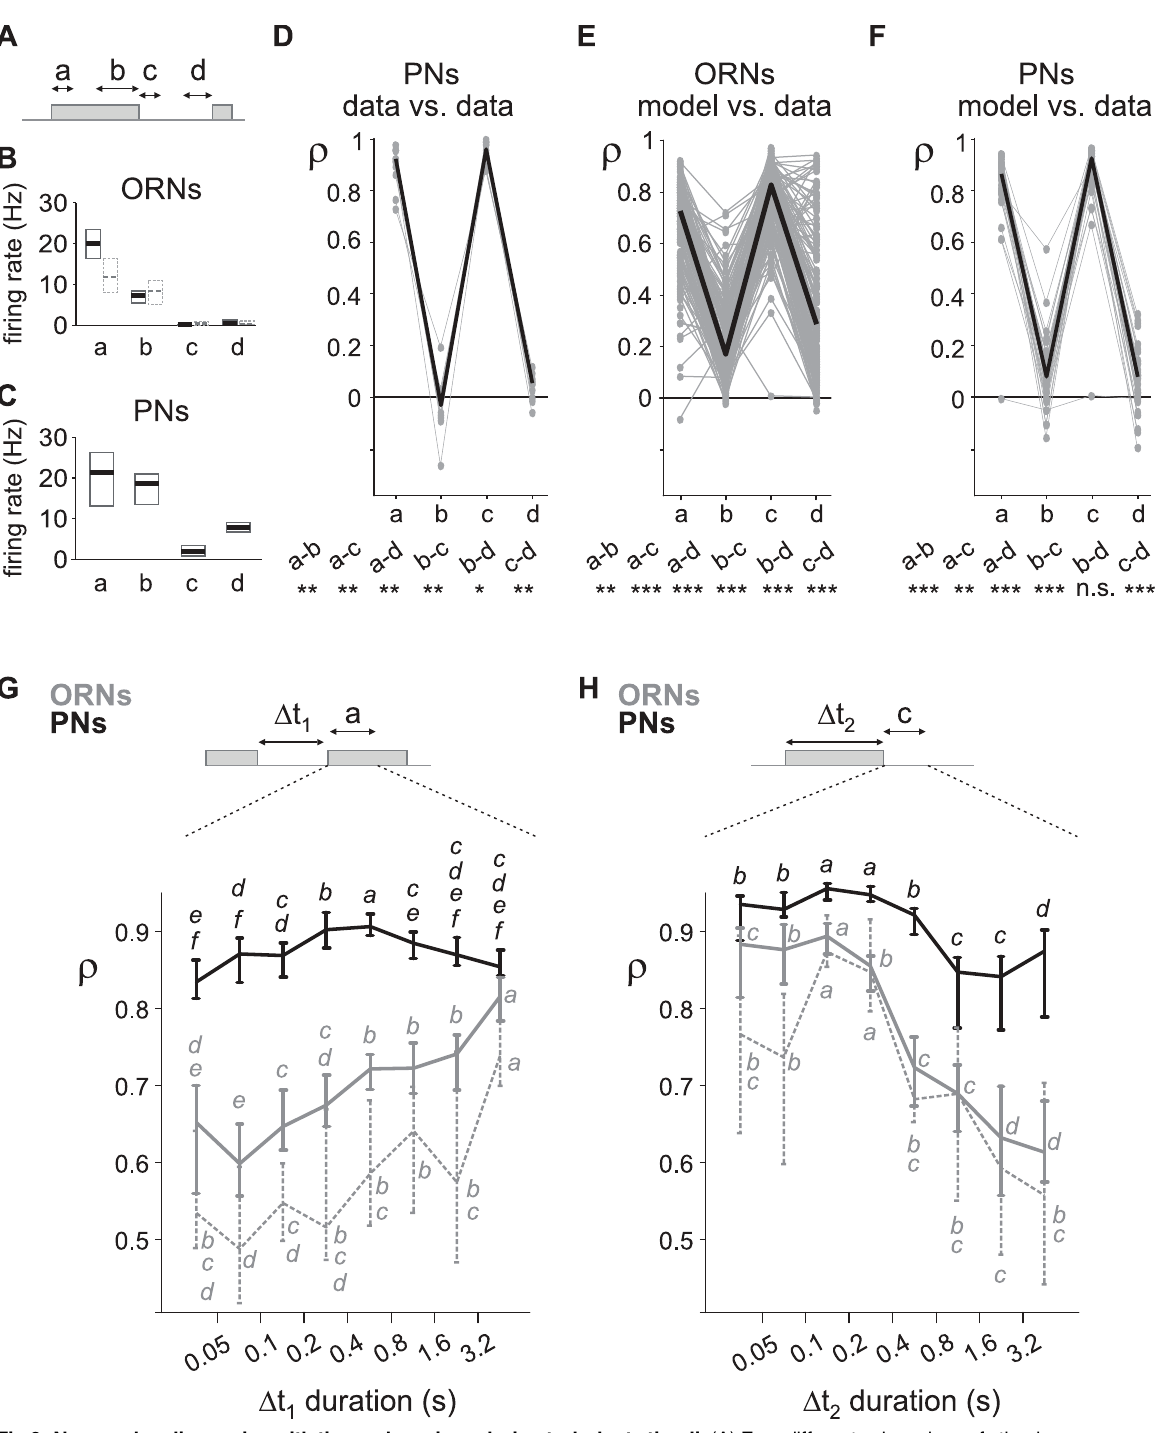
Fig 8. Neuronal coding varies with time sub-regions during turbulent stimuli. (A) Four different sub-regionsof stimulus sequenceswere definedwith (a) onset of puffs, (b) end of long puffs, (c) offset of puffs and (d) end of long blanks; see text for detailed definition.(B) (ORNs and in dotted grey the subpopulation of ORNs stimulatedwith pheromone loads of 10 -5 and 10 − 4 ng) and (C) (PNs): median values and bootstrapconfidenceintervals(95%) of firing rate in the 4 sub-regions.(D) Correlation coefficient between consecutive responses of PNs to a sequenceturbulent stimuli for the 4 sub-regionsdefinedin (A). Distance was 16 m. Cell number= 13. For each cell, 4 grey dots joinedby a grey line represent the medianvalues of correlationcoefficients θ duringsub- regions.Black line joins the median values. Bottom: dual tests betweensub-regions( * : p < 0.05, ** : p < 0.01, *** : p < 0.001,n.s.: non-